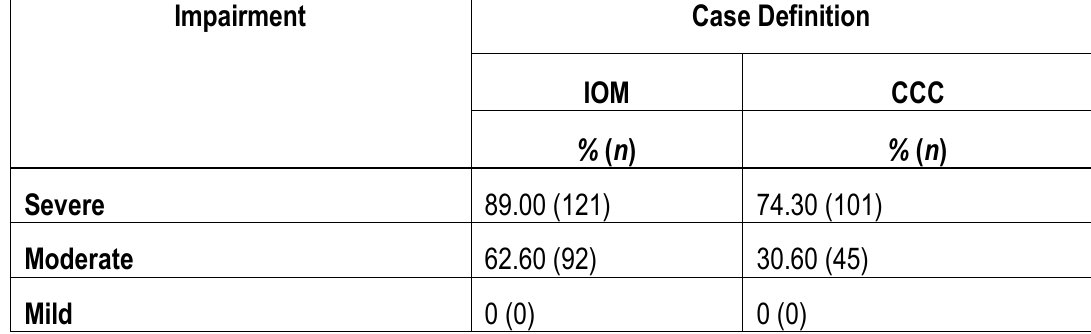
Table 5. Descriptive statistics of the frequency of participants who met case definition(s) within each